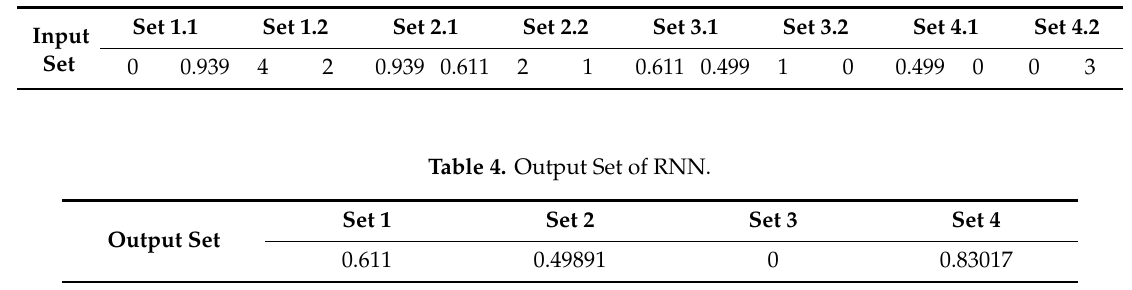
Table 3. Input Set of RNN.